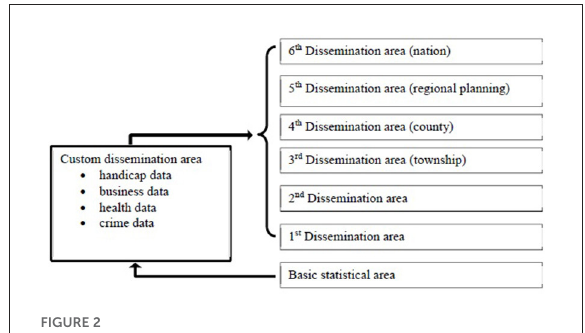
FIGURE2 Geographical statistical classification of spatial units as per